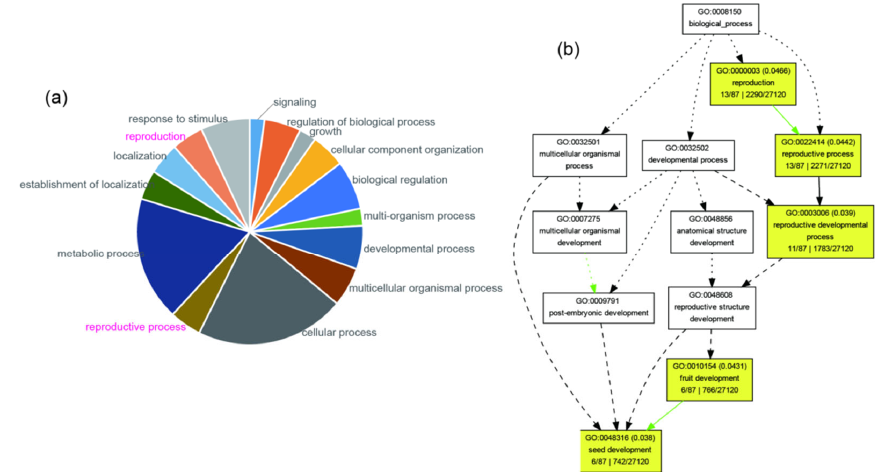
Figure 6. Analyses of genes showing elevated differentiation. ( a ) Pie chart of second-level gene ontology (GO) terms (biological process) of genes showing outlier F st values. ( b ) Graphical results showing enriched GO terms (second to sixth level; highlighted with yellow color) of genes containing outlier SNPs.